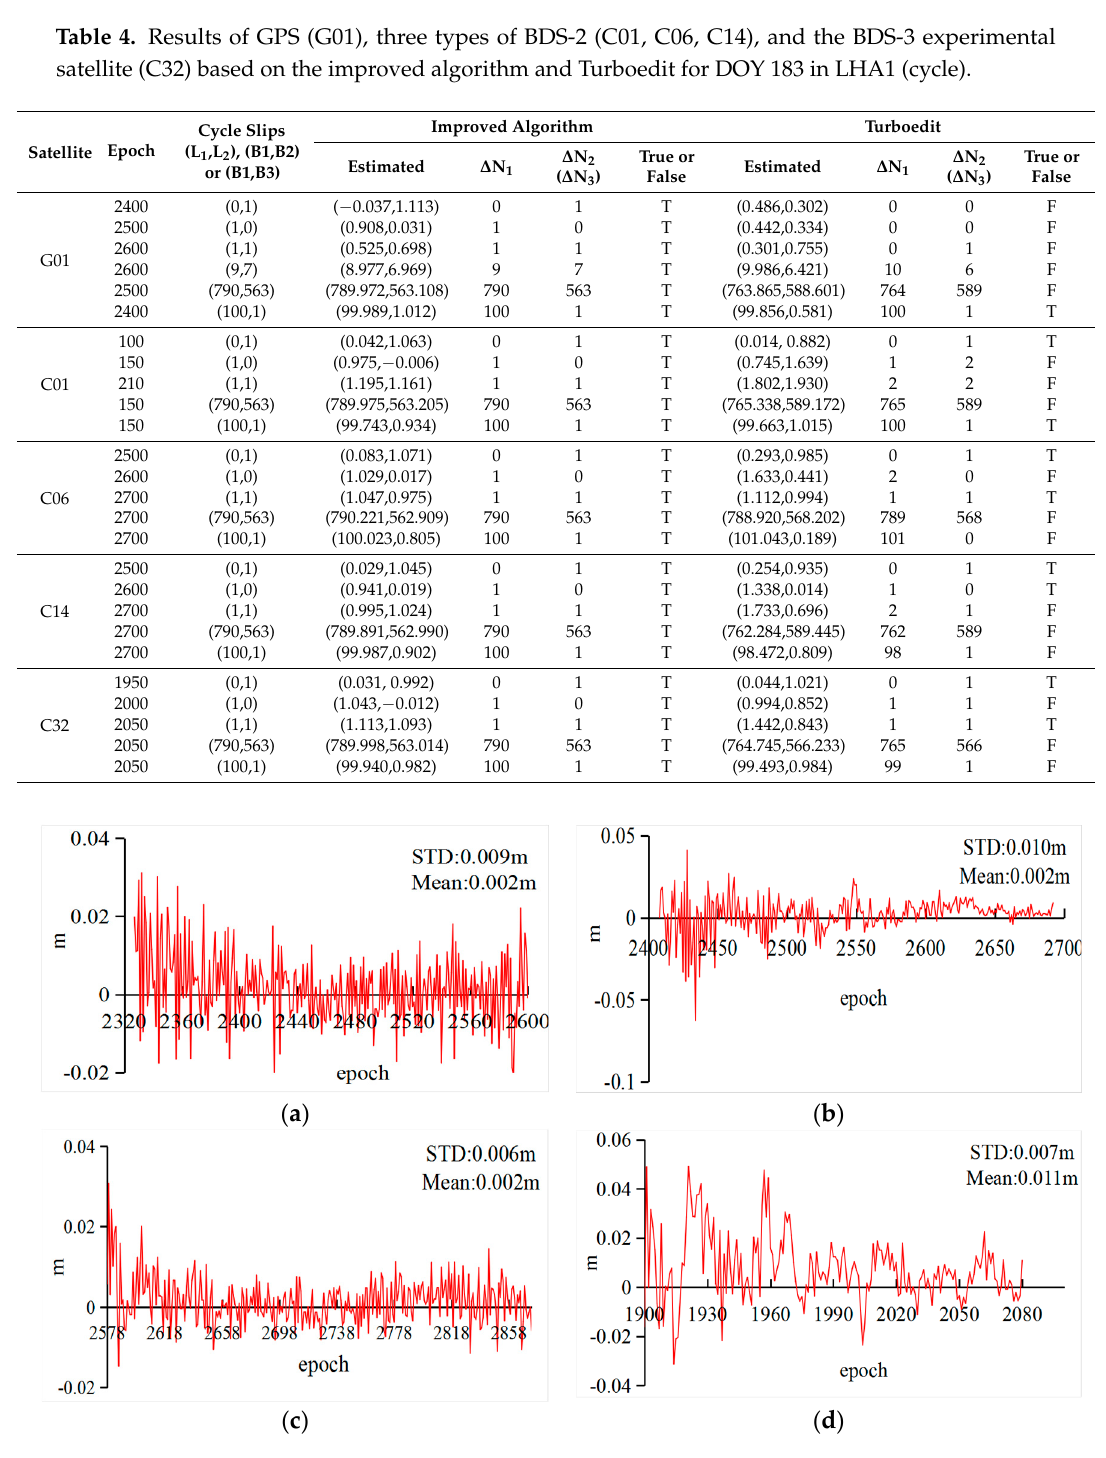
Satellite Epoch